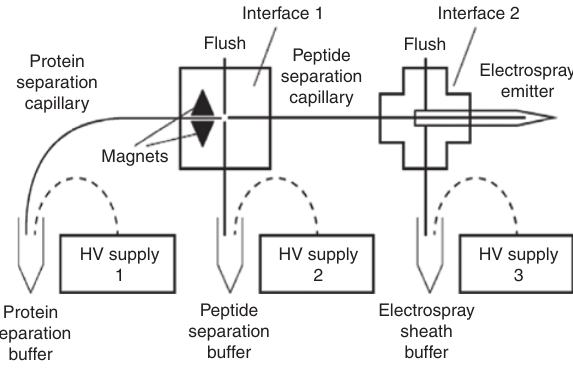
Figure 8: Principle of the two-dimensional CE system incorporating a replaceable enzyme microreactor. This image was reprinted from Li et al. (2011b) with permission from